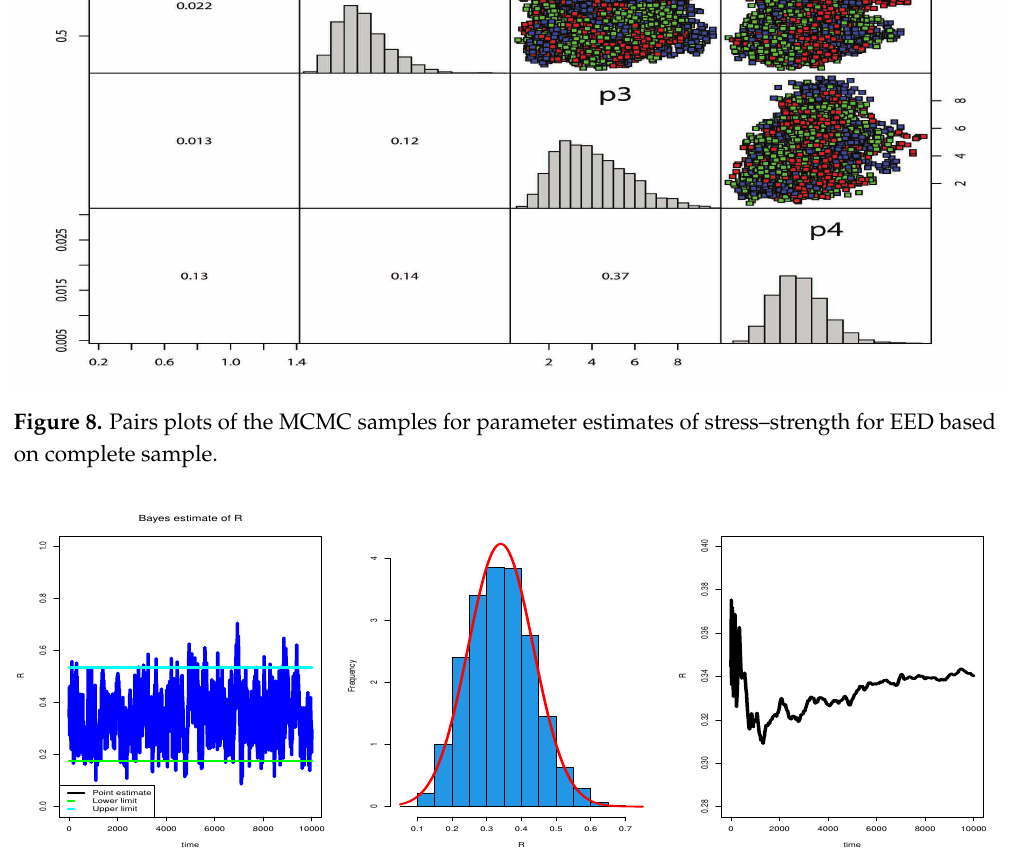
Figure 9. Trace and normal curve of posterior distribution for MCMC estimation of reliability stress–strength for EED based on complete sample. Table 8. ML and Bayesian estimates for reliability of stress–strength